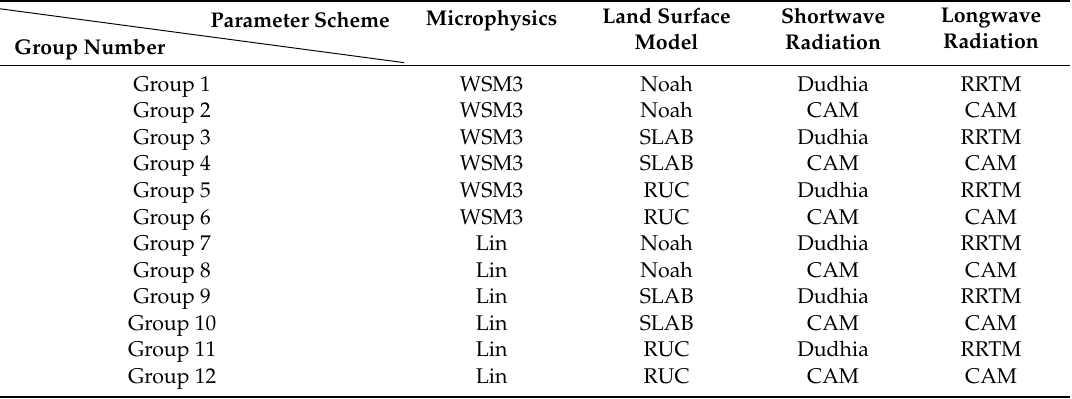
Table 3. The 12 sets of parameterization scheme combinations. (WSM3: WRF Single–Moment 3 class, SLAB: 5-layer di ff usion scheme, RUC: Rapid Update Cycle, CAM: Convection-allowing Model, RRTM:Rapid radiative Transfer